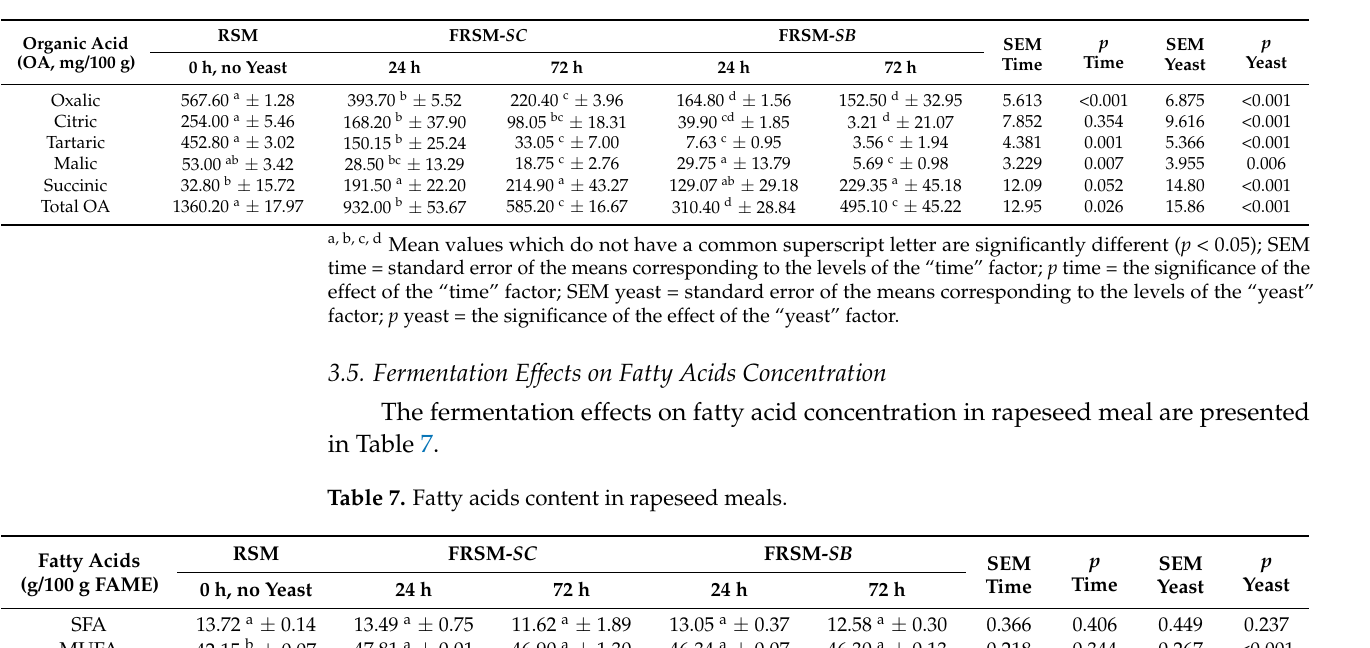
Table 6. Organic acid (OA) content in studied rapeseed meal samples.